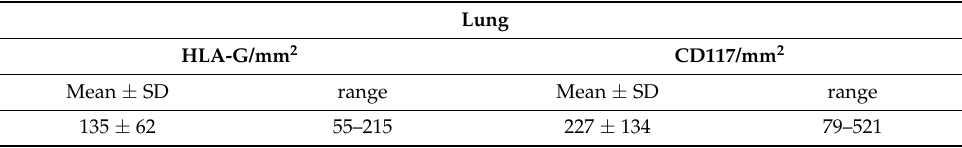
Table 5. Enumeration of HLA-G + cells and CD117 cells/mm 2 in IPF.